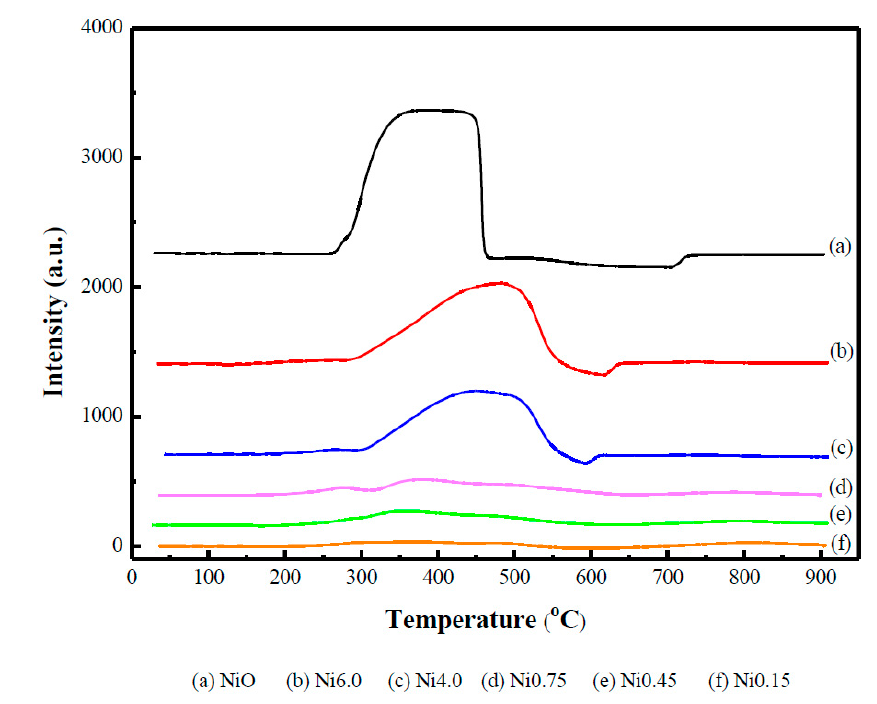
Figure 2. H 2 -TPR profiles of Ni-Ce-ZrO δ catalysts.